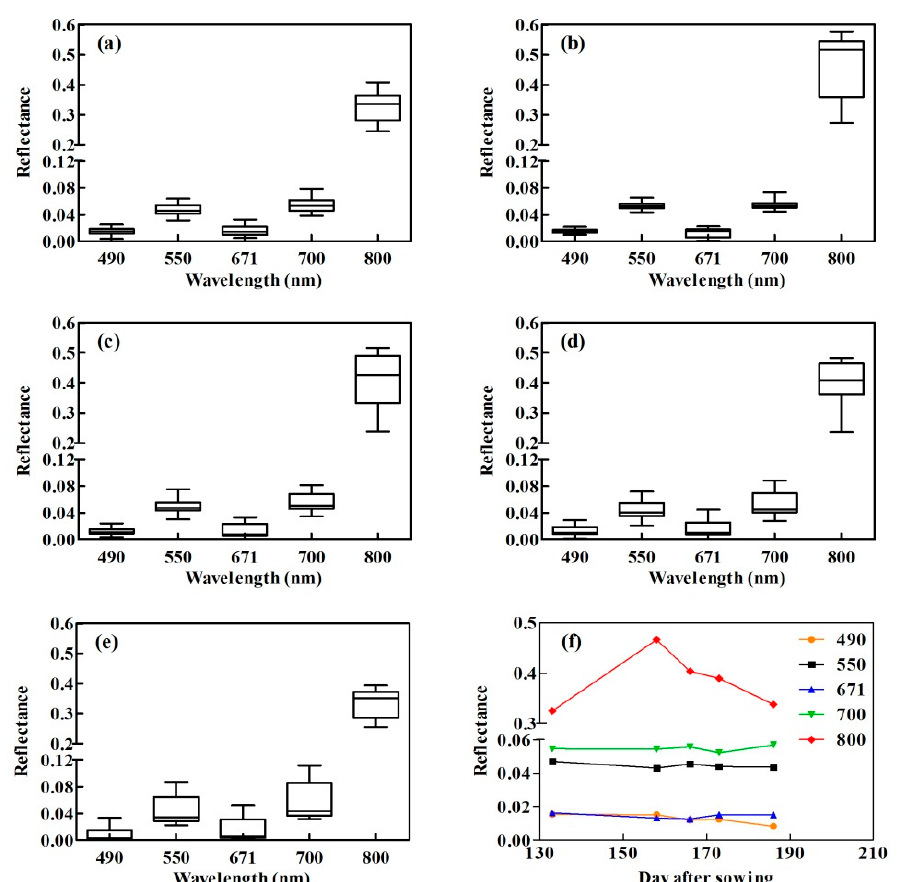
Figure 3. Canopy spectral reflectance of the narrowband multispectral image at various growth stages and days after sowing (DAS). ( a ) jointing stage, DAS = 133; ( b ) booting stage, DAS = 158; ( c ) heading stage, DAS = 166; ( d ) anthesis stage, DAS = 173; ( e ) grain filling stage, DAS = 186; ( f ) the five critical growth stages.